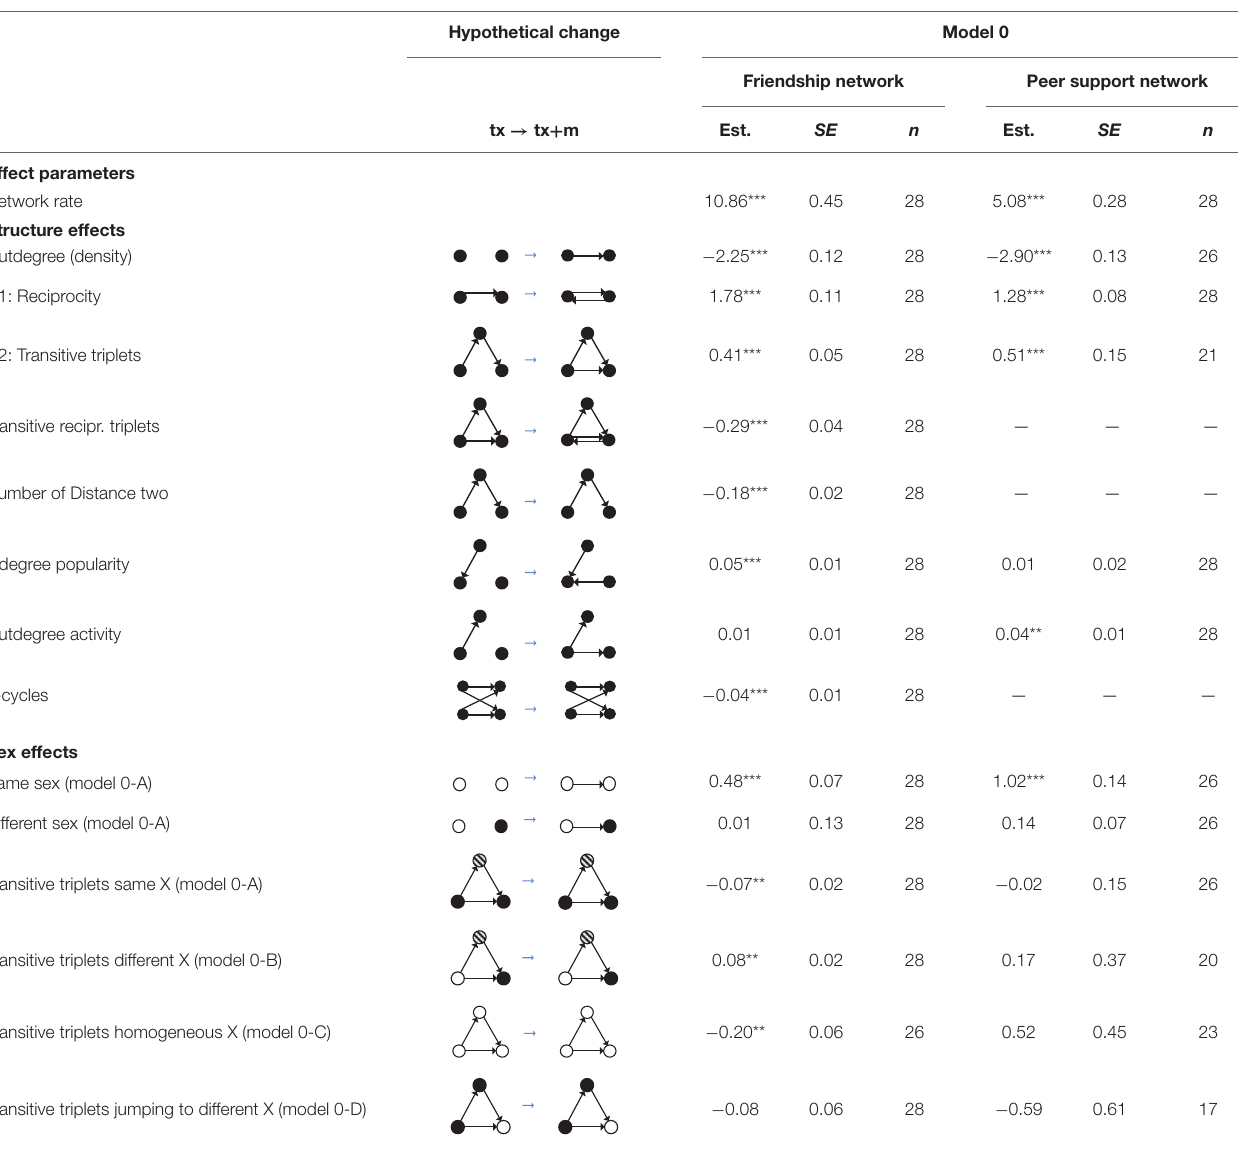
TABLE 3 | Results from Rsiena analysis that test the role of